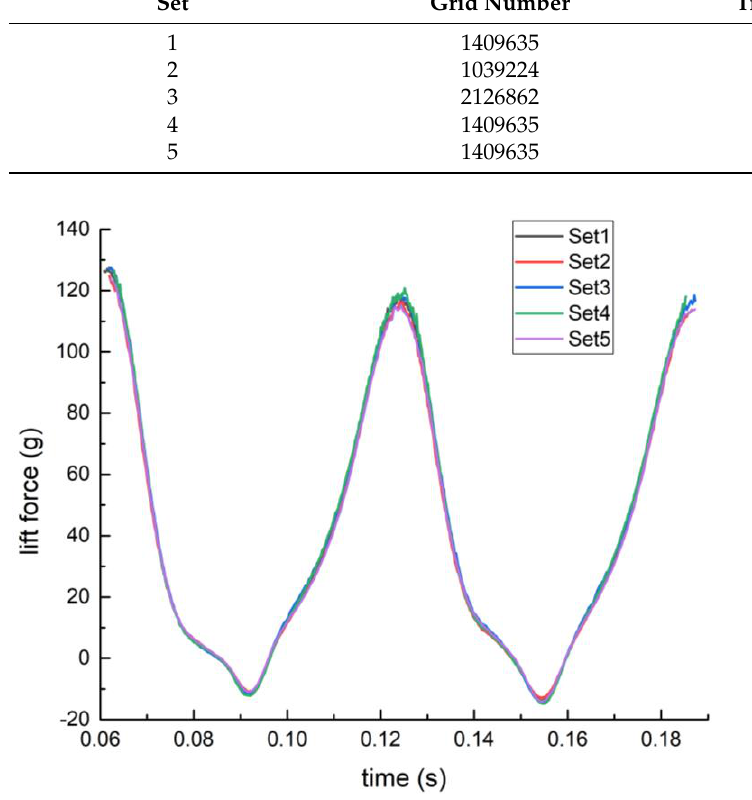
Figure 12. Comparison of different types of grid numbers and time steps.